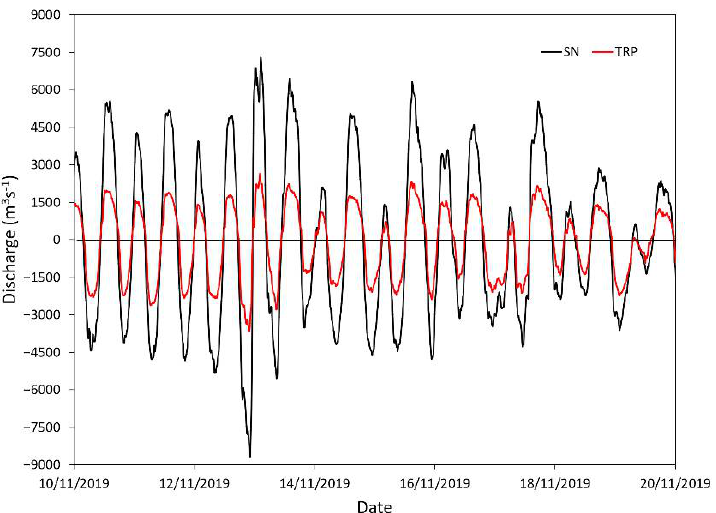
Figure 6. Time series of discharge calculated at TRP and SN channel sections, showing the period of 10–20 November 2019, which includes the second record storm surge of 12 November 2019.